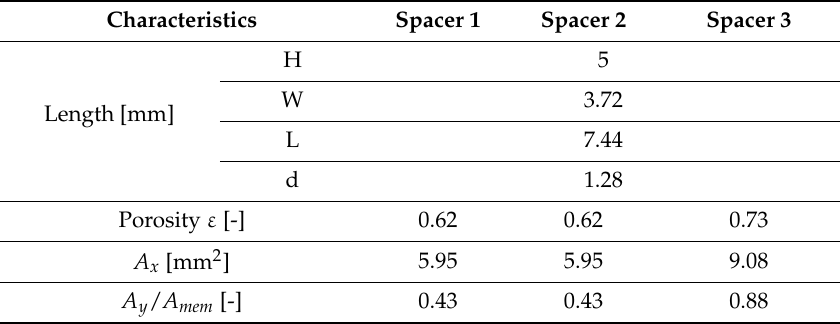
Table 1. Porous spacer characteristics. (Dimensions of porous spacers, Porosity, Cross sectional intrinsic area at a boundary in the x direction A x , and ratio of cross sectional intrinsic area at a boundary in the y direction A y to total area of membrane A mem